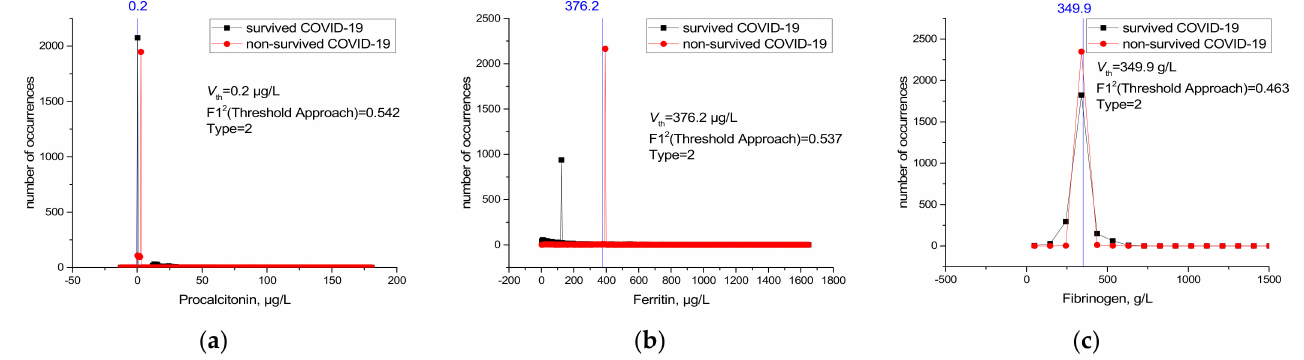
Figure 9. Histogram distributions and F1 2 results of ( a ) procalcitonin, ( b ) ferritin and ( c ) fibrinogen properties, according to the single-cut-off value approach in estimating COVID-19 mortality. V th (blue line) is the threshold for detecting COVID-19 mortality.